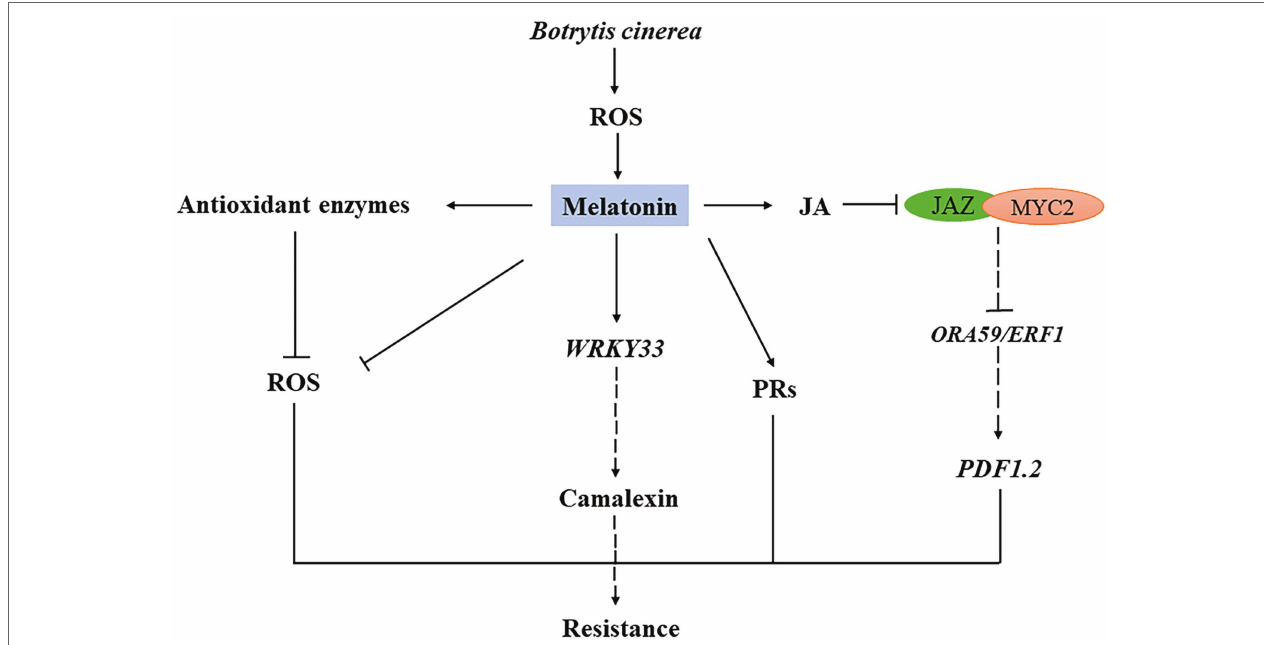
FIGURE 6 | Schematic model of the role of melatonin in plant resistance to B. cinerea infection. Under B. cinerea Infection, endogenous melatonin content increases and decreased transcript levels of JAZ1 and MYC2 , which are two negative genes in the JA signaling pathway. Increasing Increased melatonin content also reduces ROS level by stimulating antioxidant system enzyme genes. The increase of melatonin content leads to the upregulation of WRKY33 and defense genes ( PRs , PDF1.2 )